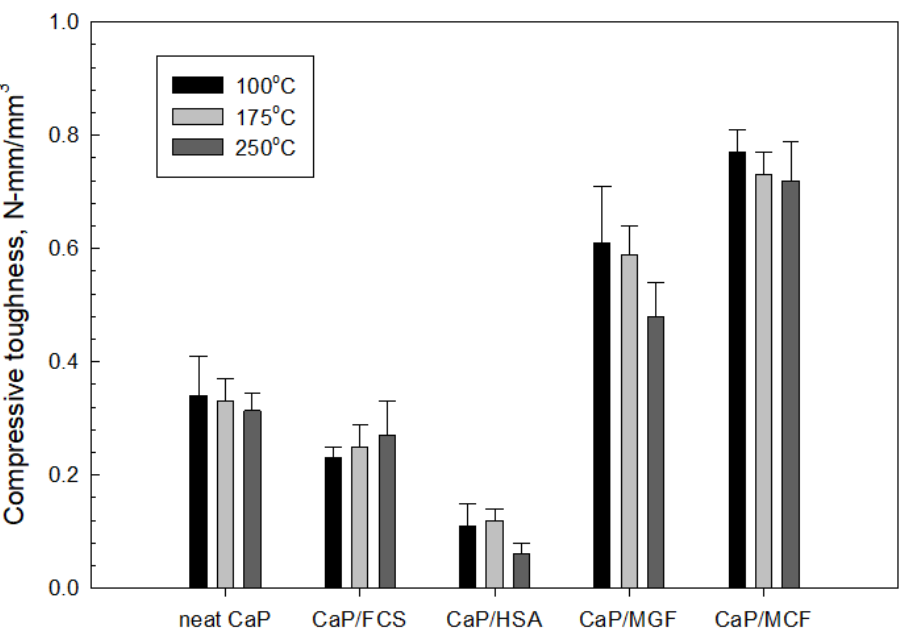
Figure 24. Compressive toughness of 100-, 175-, and 250 °C-autoclaved neat CaP and CaP cements made with different aggregates and reinforcements.